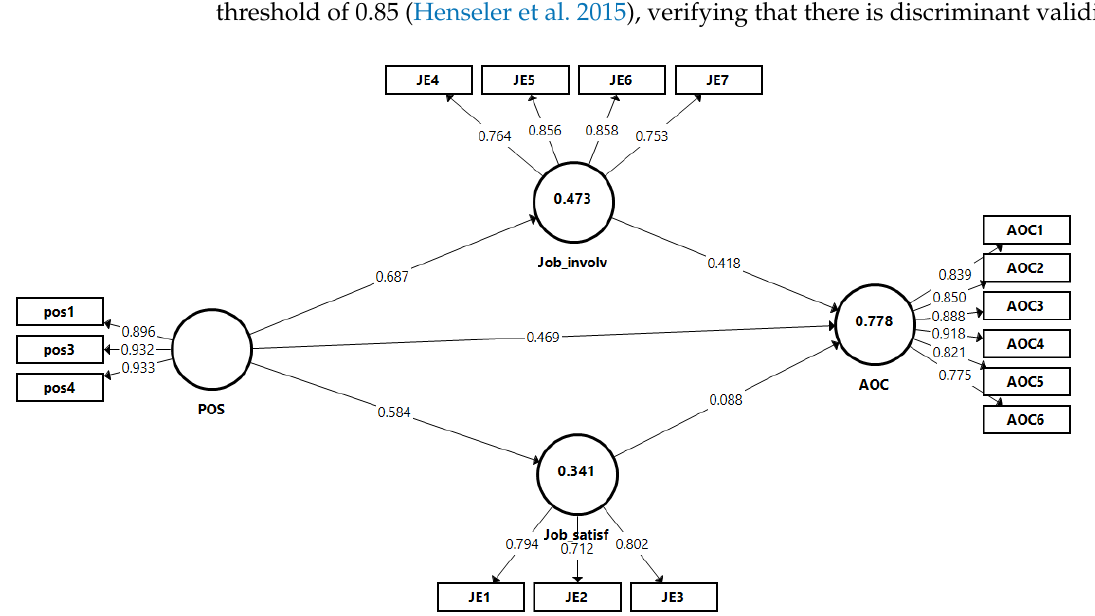
Table 1. Composite reliability, average variance extracted, correlations, and discriminant validity checks.